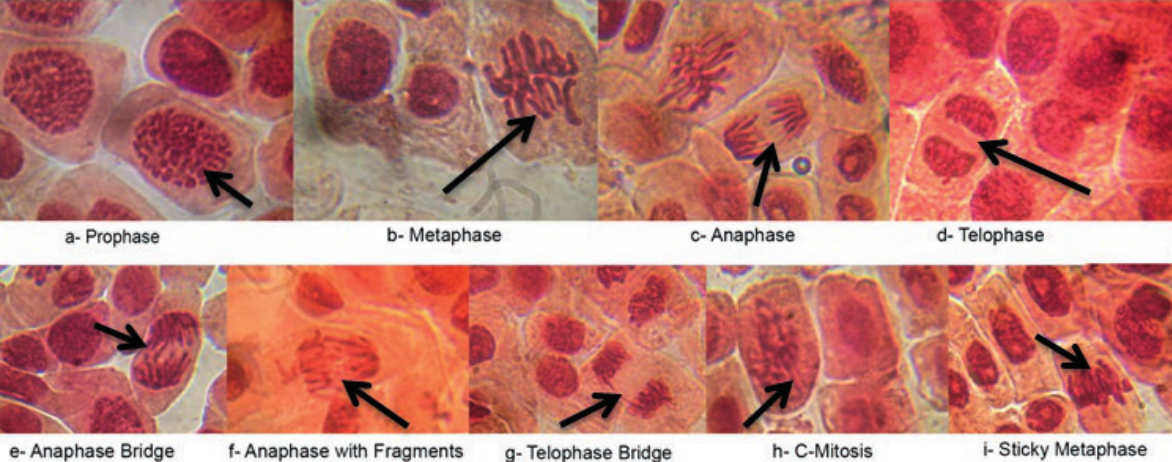
Figure 1. Representative photomicrographs of normal stages of mitotic cell divisions in treated Allium cepa root cells and observed chromo- somal